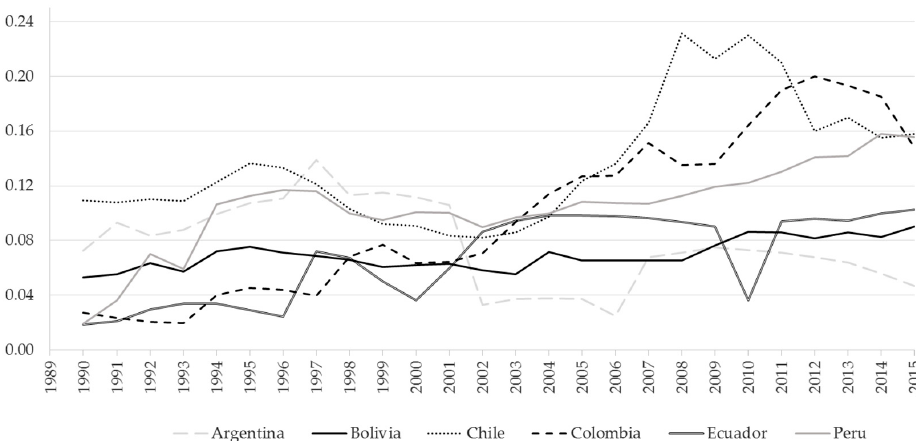
Figure 3. Average annual price of electricity in the residential sector. Source: Energy Information System of Latin America and the Caribbean (sieLAC) of the Latin American Energy Organization (OLADE) [41].